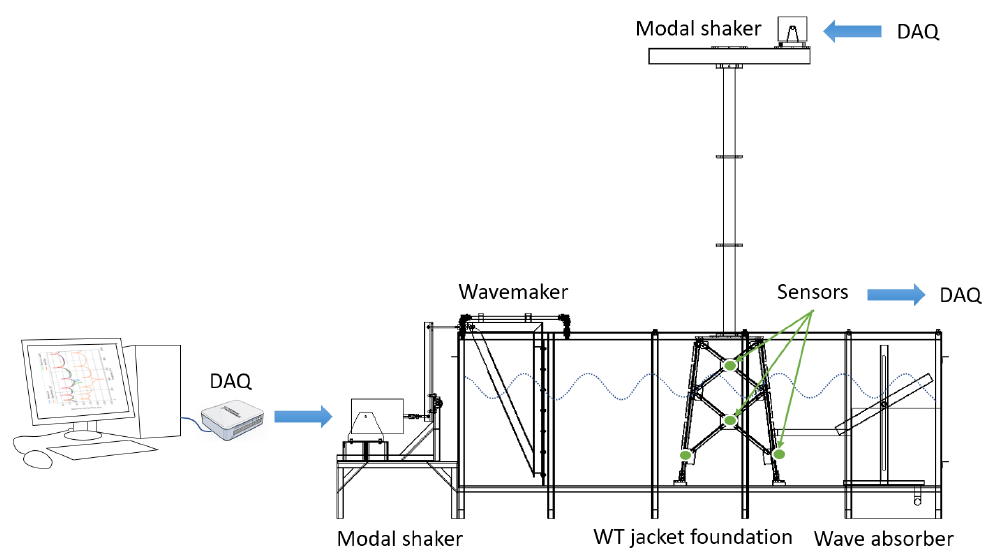
Figure 4. Conceptual design for the vibration test system (VTS) based on a wave generator chan- nel (WGC).